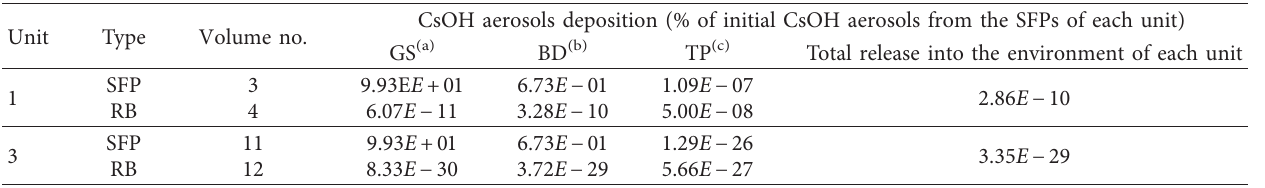
Table 8: Deposition phenomena of CsOH aerosols in the SFP and the RB of Units 1 and 3 of the second case simulated by Modified ART Mod 2.